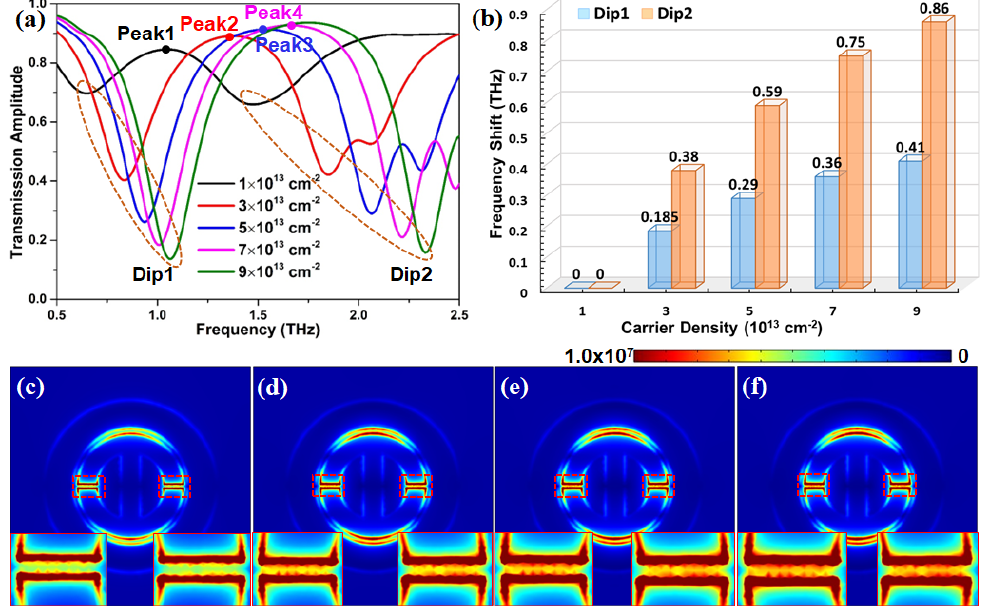
Figure 4. ( a ) Transmission spectrum with different carrier densities. ( b ) The frequency shifts versus various carrier densities at two major resonance dips of the proposed graphene metasurface. ( c – f ) Dis- tributions of the electric field for the corresponding transmission peaks as denoted in panel ( a